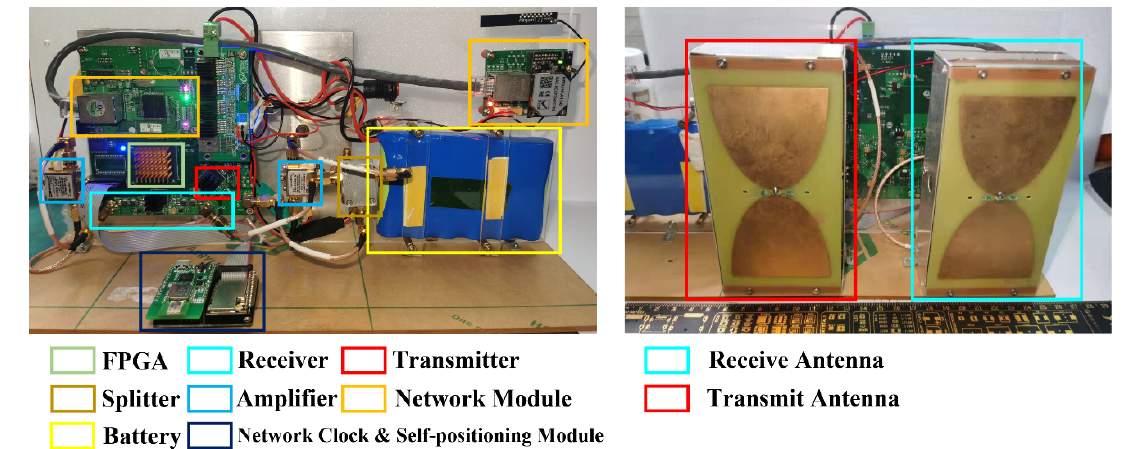
Figure 2. The prototyped radar system ( left ) and its antennas ( right ).